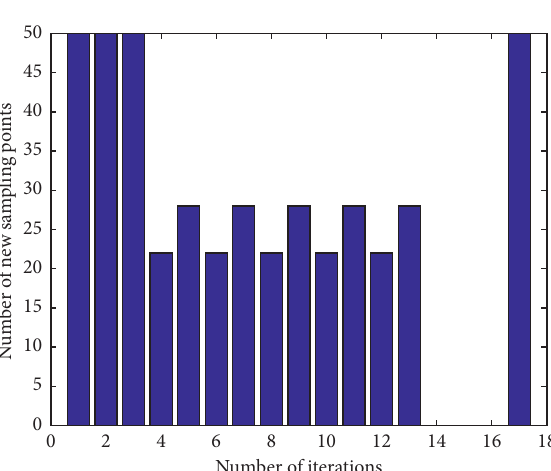
Figure 5: Number change of new sampling points.